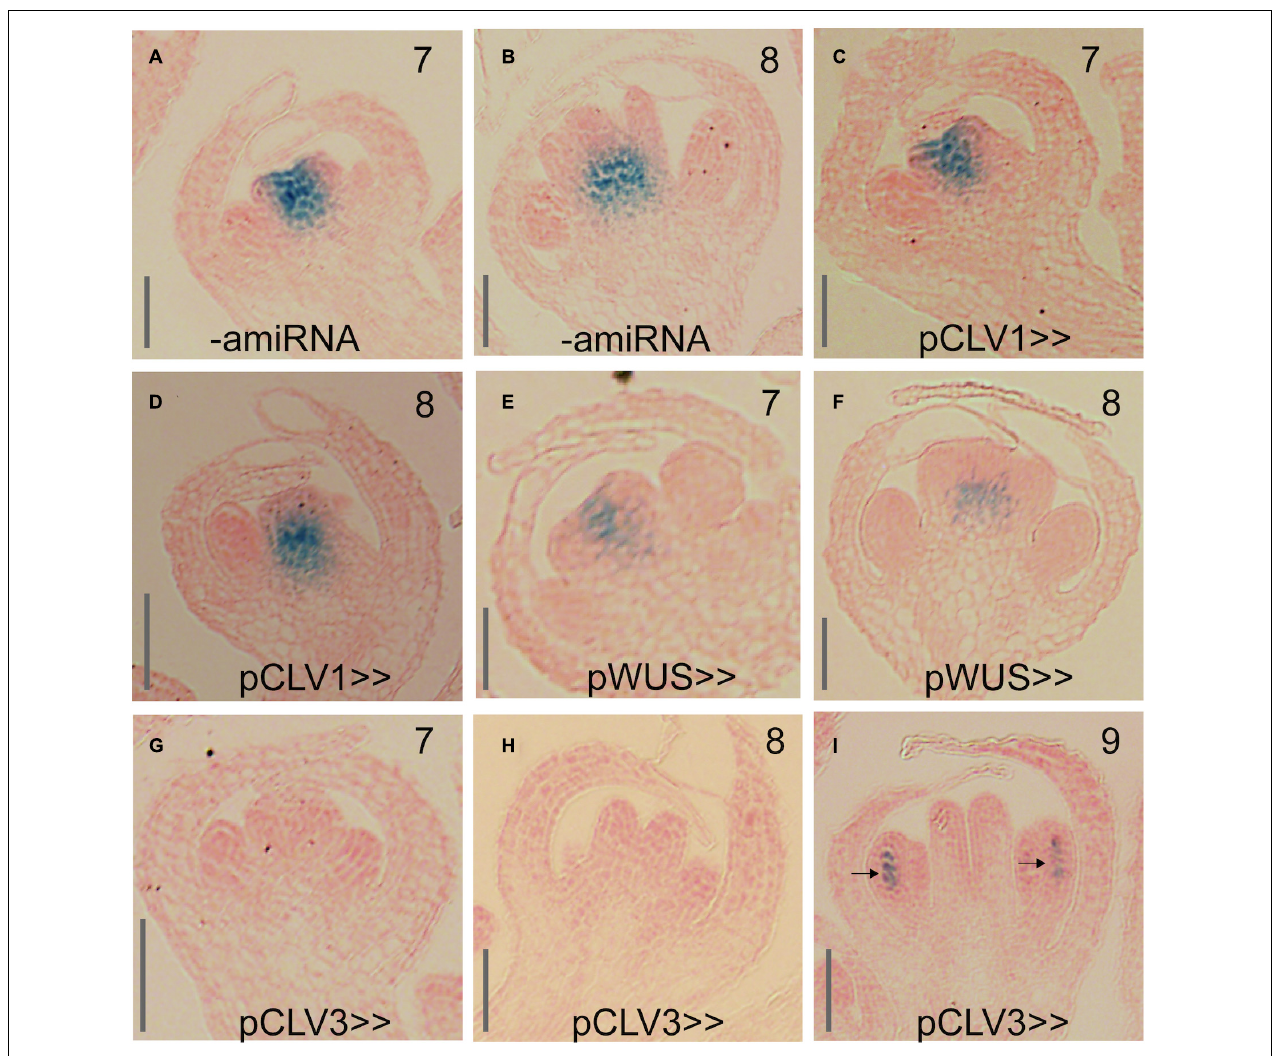
FIGURE 7 | Effect of KNU-amiRNA expression from different driver lines on KNU expression. (A,B) pKNU::KNU-GUS activity in plants that do not express the KNU-amiRNA. (C,D) pKNU::KNU-GUS activity in plants expressing the KNU-amiRNA from the CLV1 driver. (E,F) pKNU::KNU-GUS activity in plants expressing the KNU-amiRNA from the WUS driver. (G–I) pKNU::KNU-GUS activity in plants expressing the KNU-amiRNA from the CLV3 driver. In (I) , GUS signal in anthers is marked by arrows. Approximate floral stages are indicated by numbers. Scale bars: 25 µ